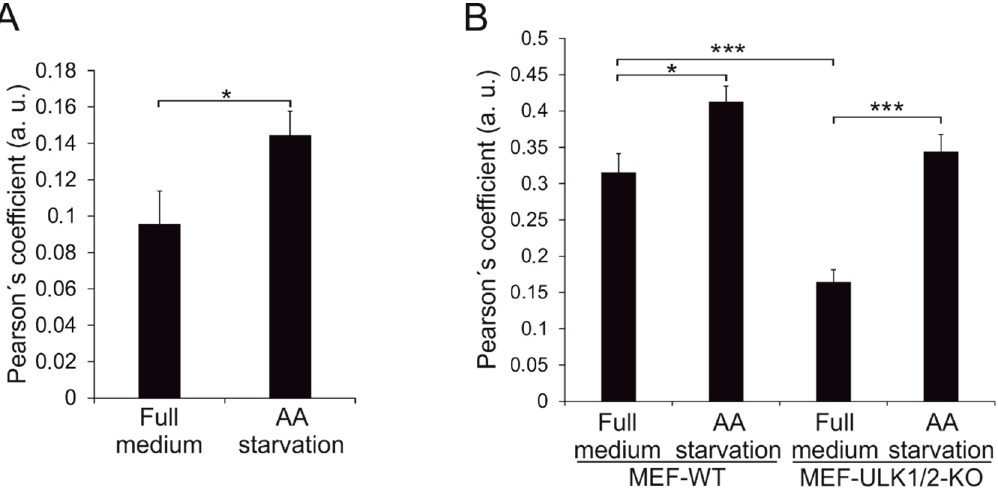
Figure 9. Quantitaive analysis of colocalization for Beclin 1-WT with ER markers in non-starved and amino-acid starved HEK293 and MEF cells. ( A ) Colocalization of Beclin 1-WT and calreticulin in HEK293 cells inducibly expressing Twin-StrepII-HA-Beclin 1-WT. The cells were induced with 2 μ g/mL tetracycline for 24 h, either kept in full medium or starved in amino-acid (AA) free medium for 1 h, fixed and labelled with anti-HA and anti-calreticulin. Imaris 9.2 was used to quantify the colocalization between Beclin 1-WT and calreticulin on confocal microscopy images (Figure S13). Results are shown as mean of Pearson´s correlation coefficient and standard error of the mean (SEM), calculated using 25 images, each containing 2 to 6 cells. A two-tailed unpaired t-test was used to test statistical significance. * p < 0.05. ( B ) Colocalization of Beclin 1-WT and BAP31 in MEF-WT and MEF-ULK1/2-KO cells transiently expressing eGFP-Beclin 1-WT. The cells were either kept in full medium or starved in amino-acid (AA) free medium for 1 h, fixed and labelled with anti-BAP31. Imaris 9.2 was used to quantify the colocalization between Beclin 1-WT and BAP31 on confocal microscopy images (Figure S14). The results are shown as mean of Pearson´s correlation coefficient and SEM for 20 cells. One-way ANOVA and Tukey Kramer post hoc test were used to test statistical significance. * p < 0.05, *** p < 0.001.